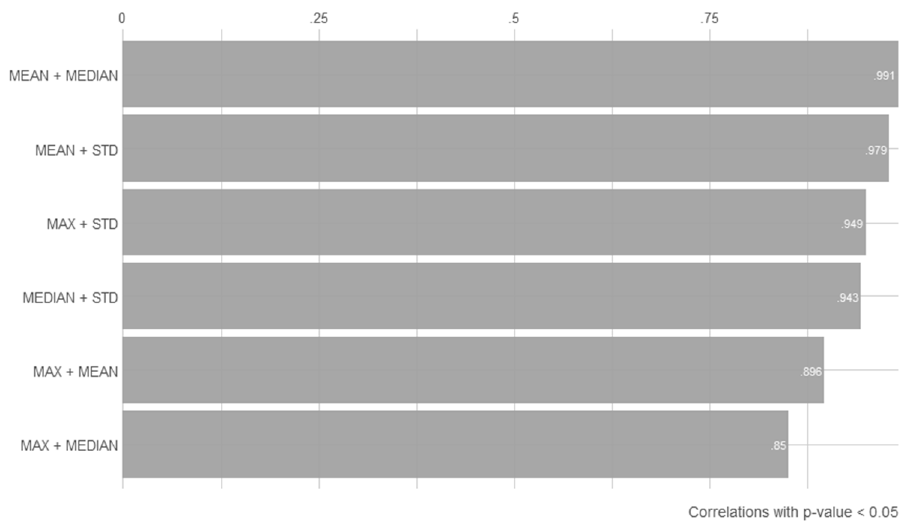
Figure 4. Results of Pearson correlation test among model features.